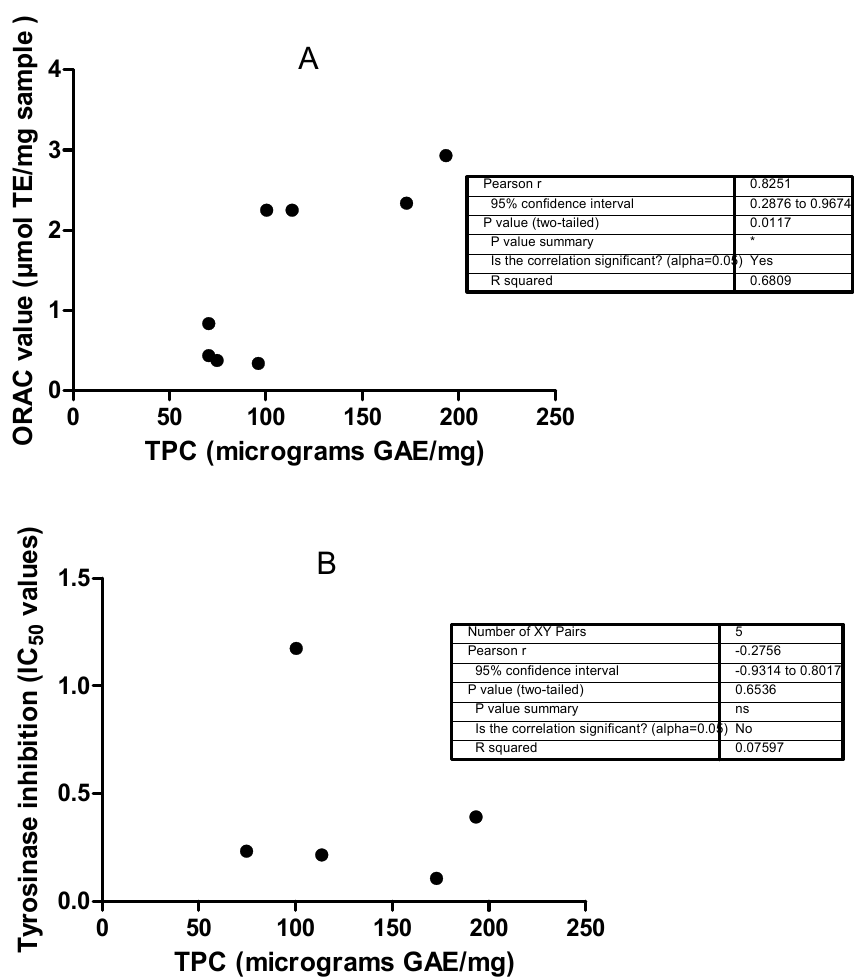
Figure 2. Correlation studies between polyphenol content and antioxidant activity ( A ) and between polyphenol content and tyrosinase inhibition ( B ). Pearson r values confirm that there is a correlation between polyphenol content and antioxidant activity measured by the ORAC method, whereas no correlation exists between polyphenol content and the inhibition of the tyrosinase enzyme.